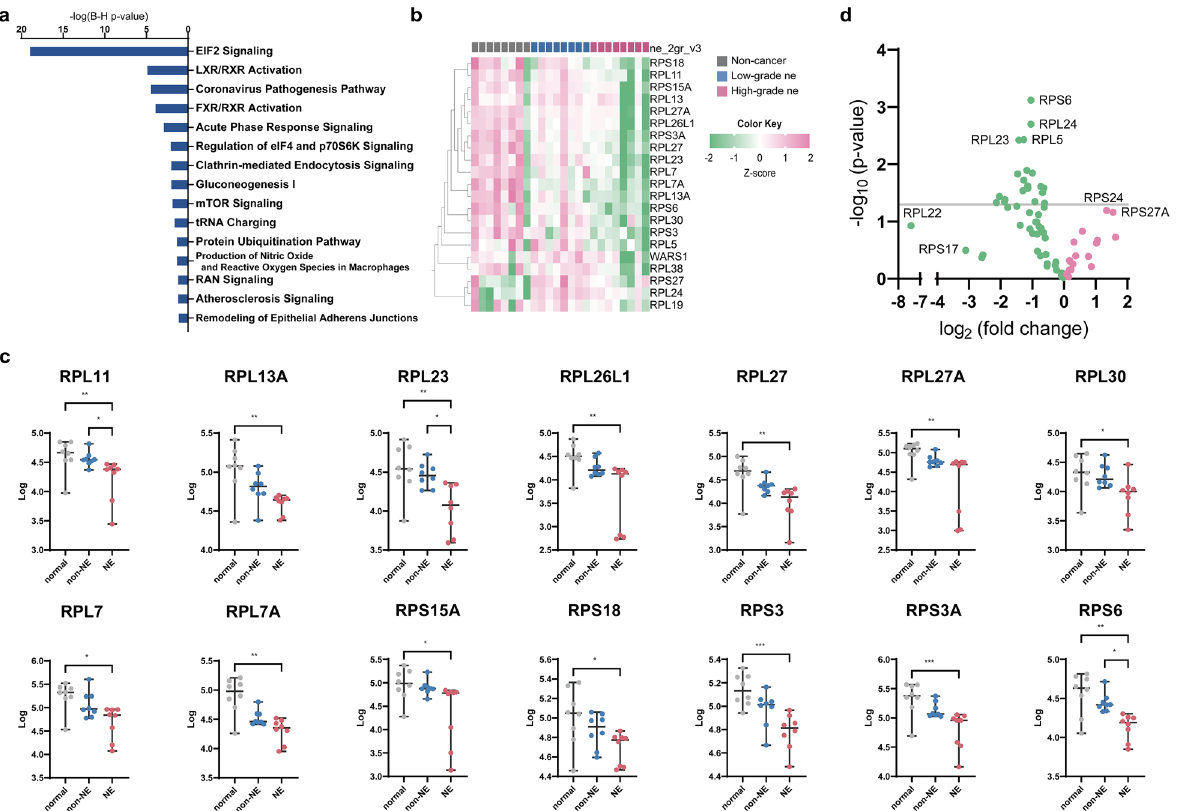
Figure 4. ( a ) The core analysis of top canonical pathways. ( b ) The heatmap of significantly differentially expressed proteins related to EIF2 signaling. This was generated with Qlucore Omics Explorer v3.7 (https:// qluco re. com). ( c ) The comparison of the intensity of molecules involved in EIF2 signaling. “*”, “**”, and “***” indicate significance at P < 0.05, P < 0.01 and P < 0.001, respectively. non-NE low-grade ne, NE high-grade ne. ( d ) The volcano plot of the identified ribosomal proteins in our dataset. Red circles show the increased expression in the high-grade ne group than in the low-grade ne group. Green circles show the decreased expression in the high-grade ne group than in the low-grade ne